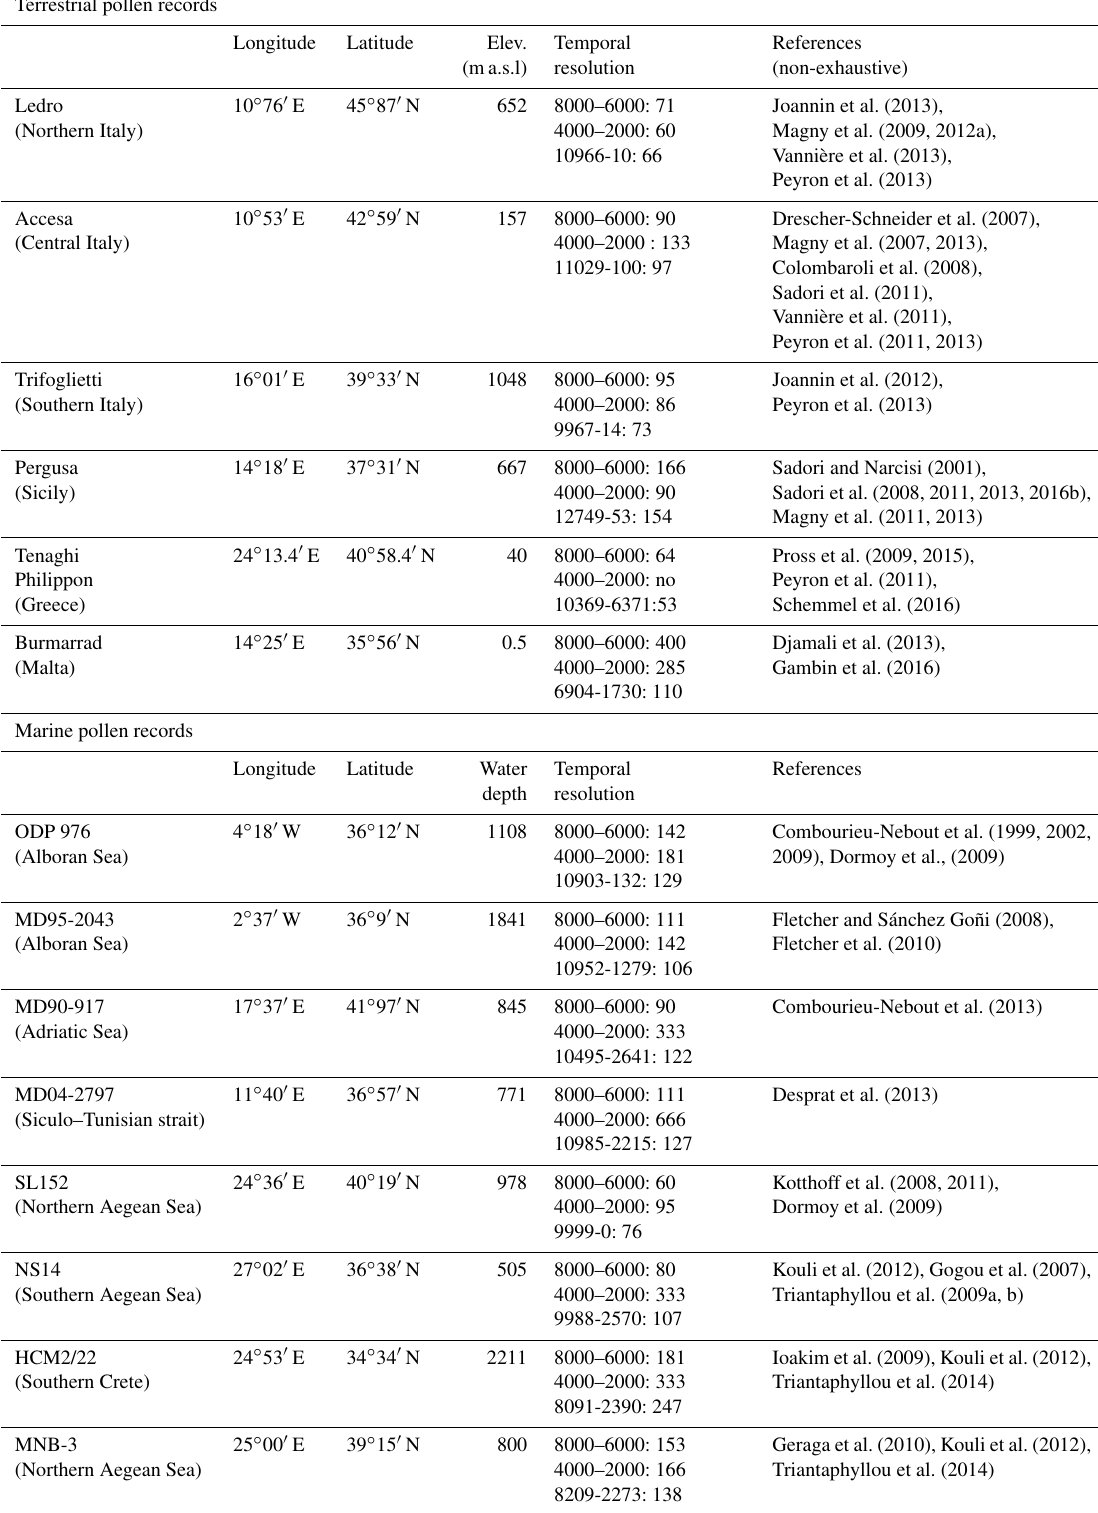
Table 1. Metadata for the terrestrial and marine pollen records evaluated. The temporal resolution is calculated for the two periods (8000– 6000 and 4000–2000) and for the entire